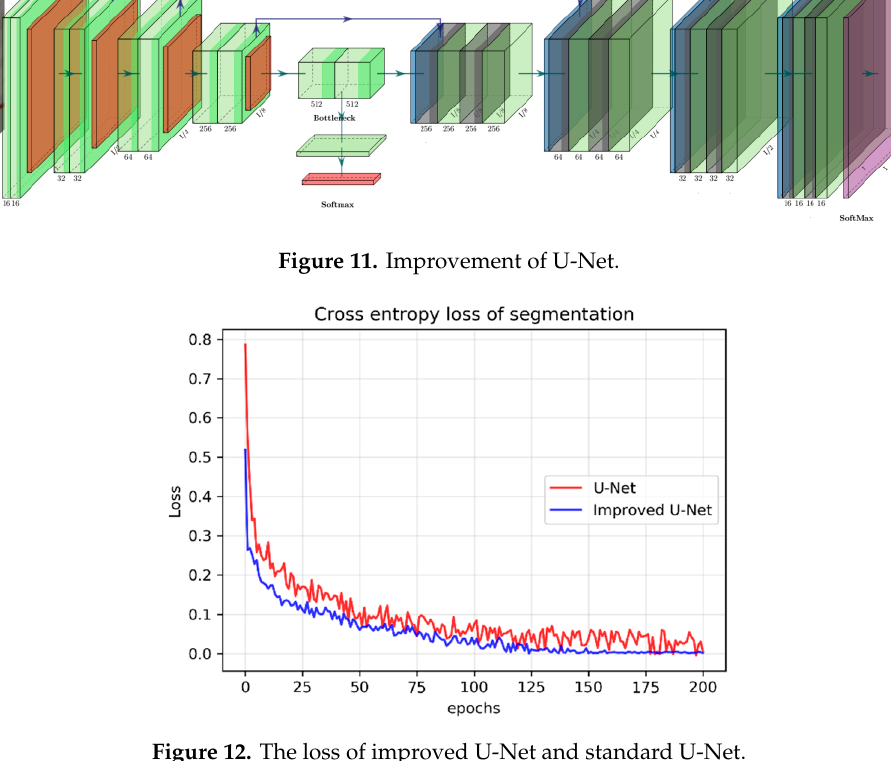
Figure 12. The loss of improved U-Net and standard U-Net.